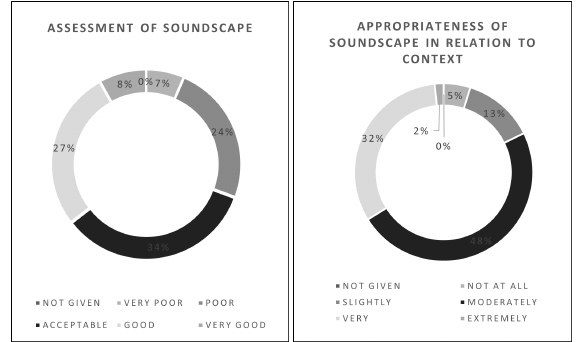
Figure 12: Assessment and appropriateness of the soundscape in the current situation.